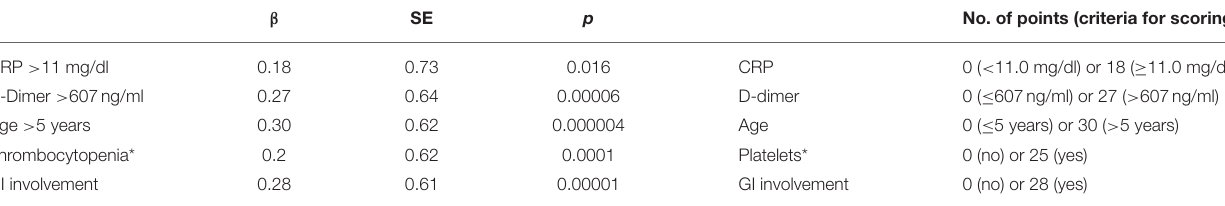
TABLE 3 | Variables included in the development of the diagnostic set and KMDscore calculation.